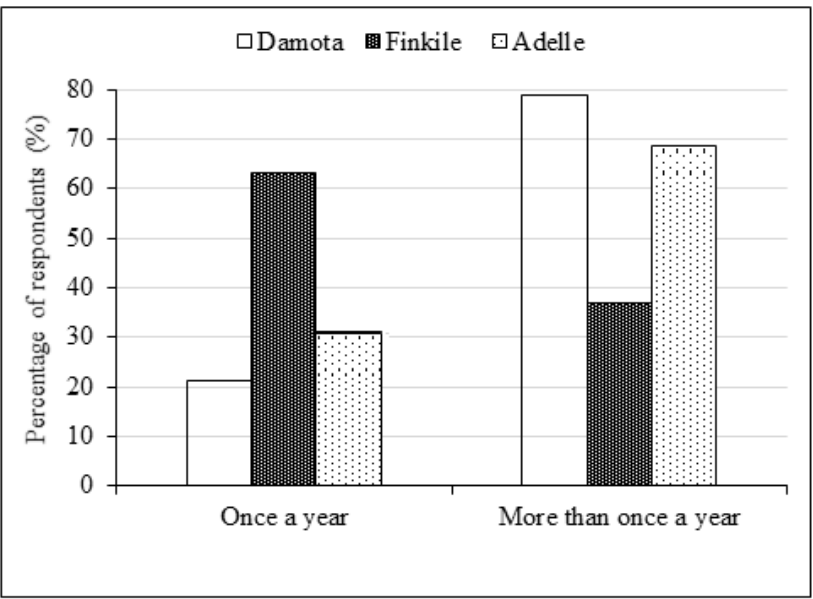
Figure 6. The frequency of crop cultivation in the three kebeles of the Haramaya District (Source: Elaborated by the Authors).